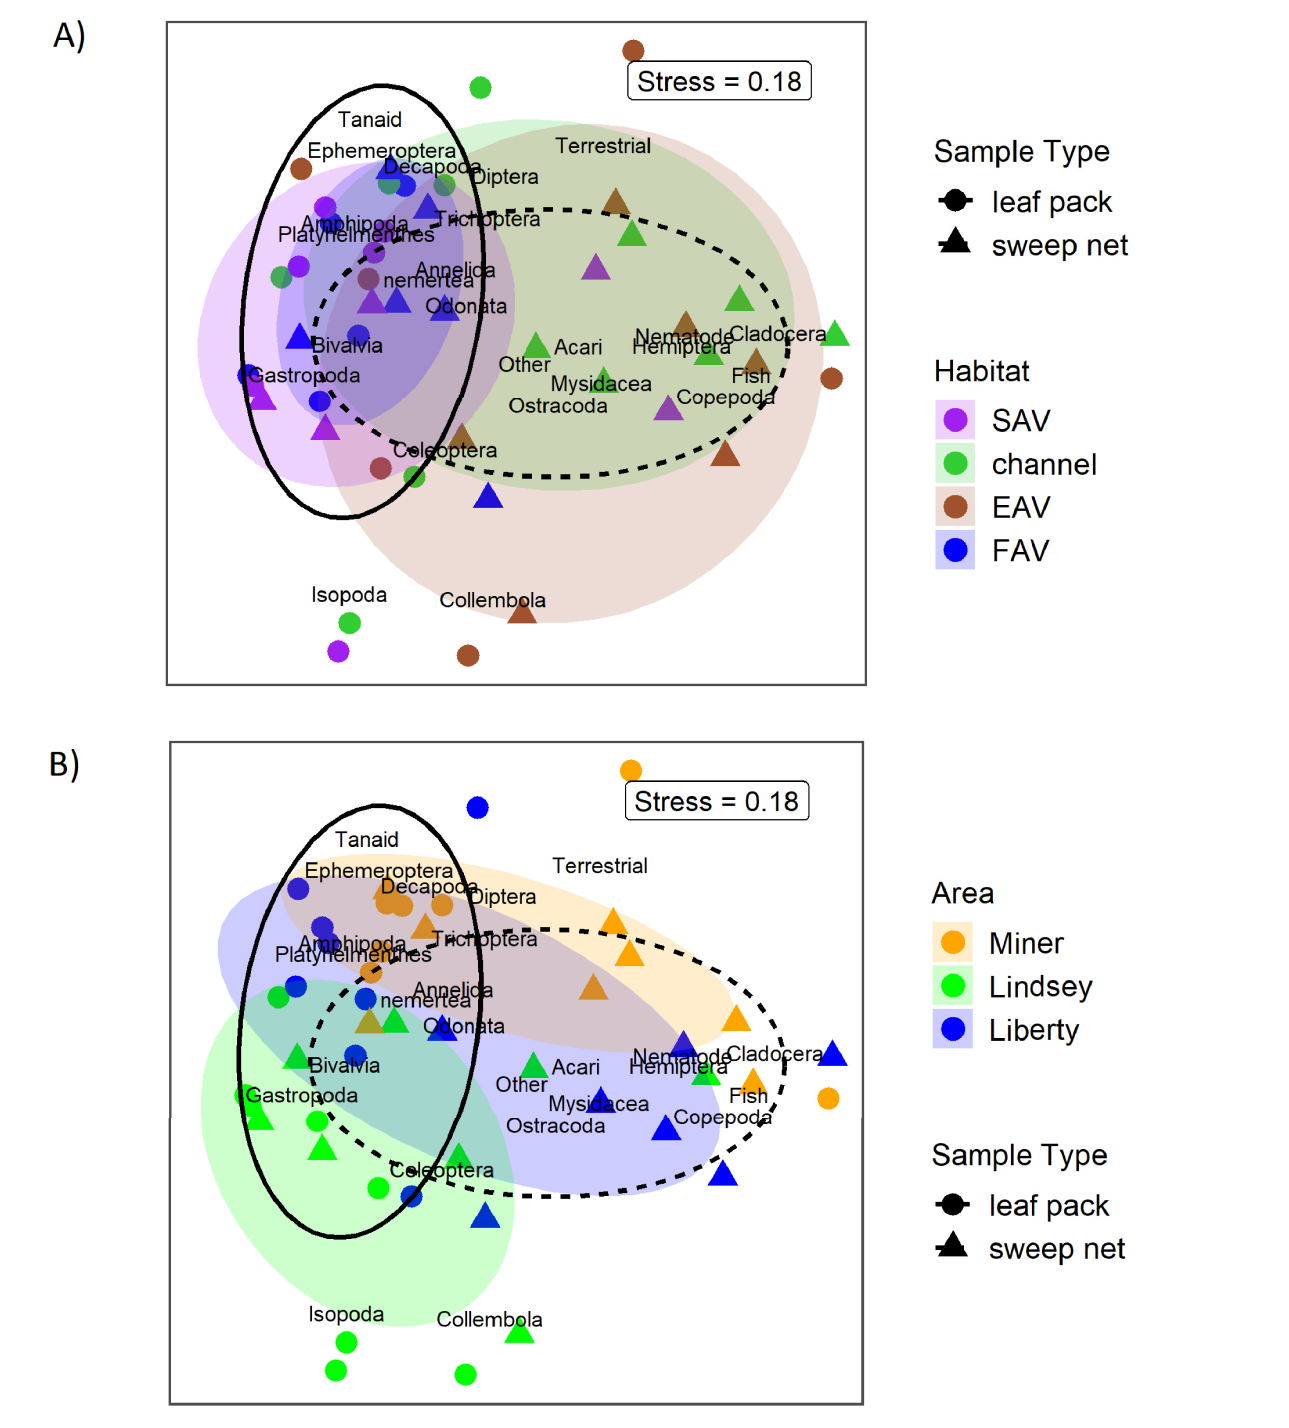
Fig 5. A) Non-metric multidimentional scaling plots (NMDS) of propotional taxonomic abundance with colored elipses showing the standard deviation of group centroids by habitat type and black outlined elipses showing grouping by sample type. Points represent samples, text represents species. Stress = 0.18. B) Plot of the same NMDS as 5A, but with colored elipses showing the standard deviation of group centroids by Area. Black outlined elipses show grouping by sample